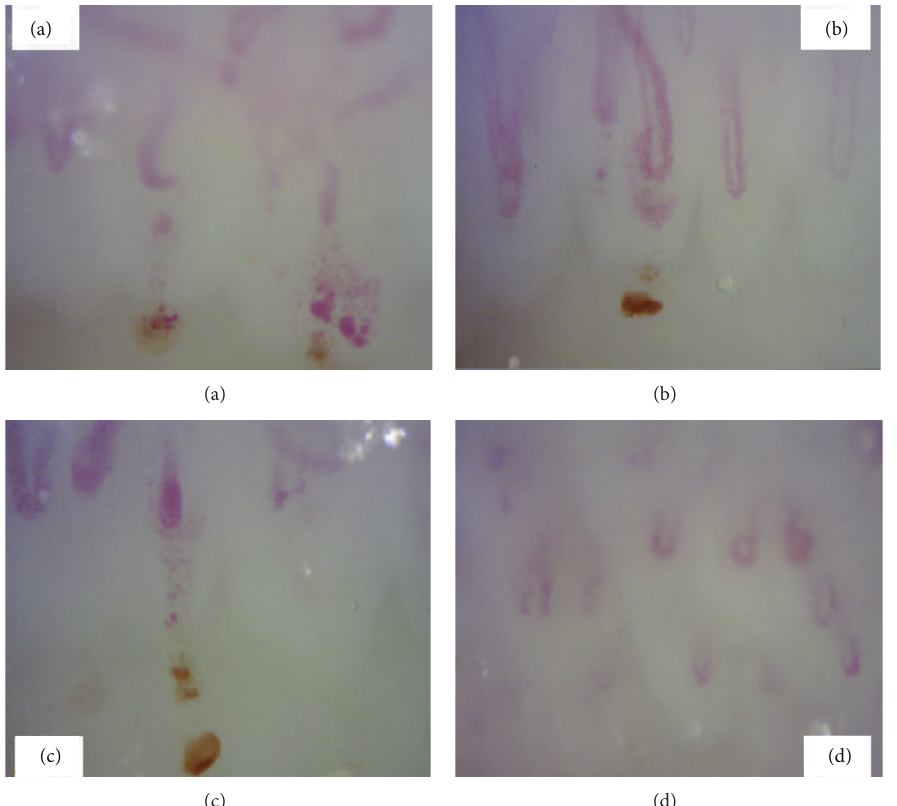
Figure 2: Capillaroscopy. (a) Moderate loss of capillaries. (b) Giant capillaries. (c) Capillary microhemorrhages. (d) Granular